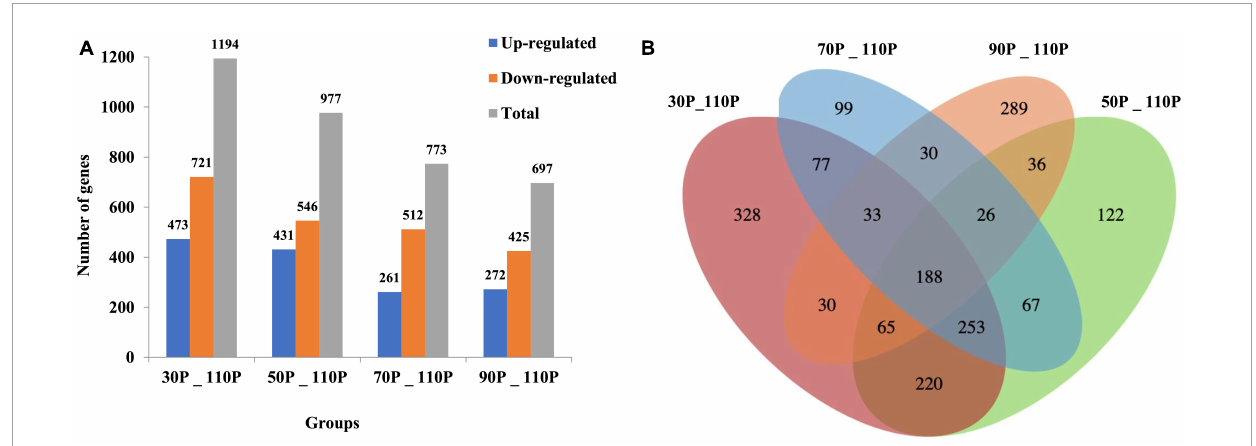
FIGURE2 Differentially expressed genes shown by a bar plot (A) and Venn diagram (B) . The histogram shows the numbers of up- and down-regulated differentially expressed genes (DEGs) in each group pairwise comparison (30P_110P, 50P_110P, 70P_110P, and 90P_110P) of Hypsizygus marmoreus . (B) Venn diagram showing the overlap in DEGs between four